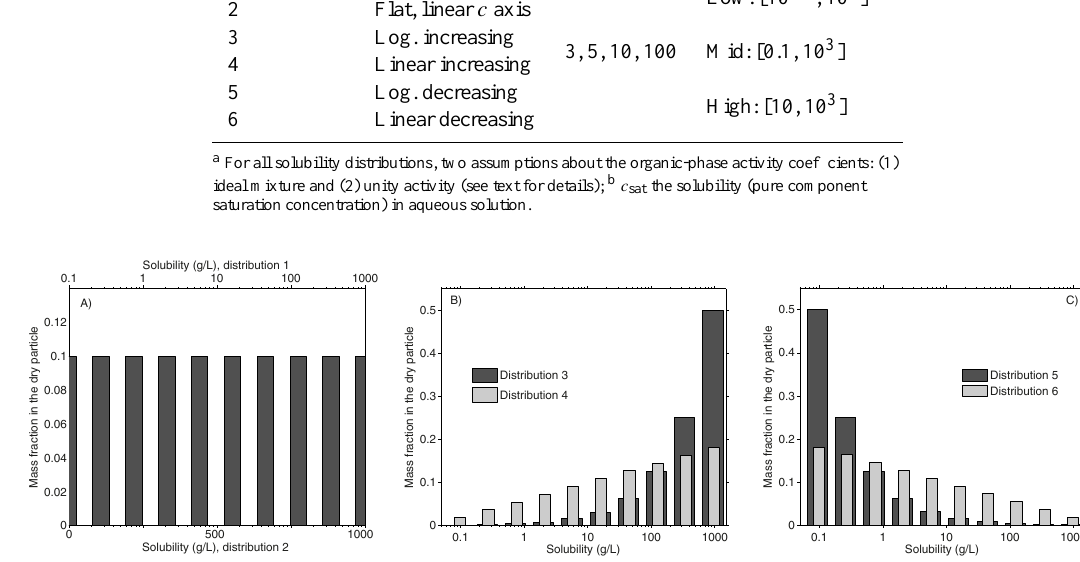
Table 2. Solubility distributions of the organic mixtures considered in this study. Distribution a Shape Number of [ c sat , min , c sat , max ,] b components (gL − 1 ) 1 Flat, log c axis Low: [10 − 5 , 10 3 ] 2 Flat, linear c axis Log. increasing 3, 5, 10, 100 Mid: [0.1, 10 3 ] 4 Linear increasing 5 Log. decreasing